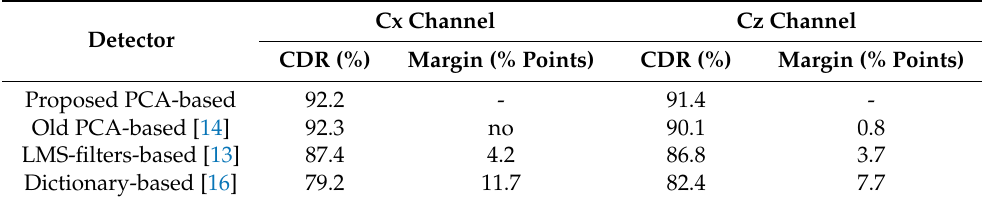
Table 1. CDR for different detectors using the 600 dpi scanned testing images, and statistically significant improvement of the proposed PCA-based